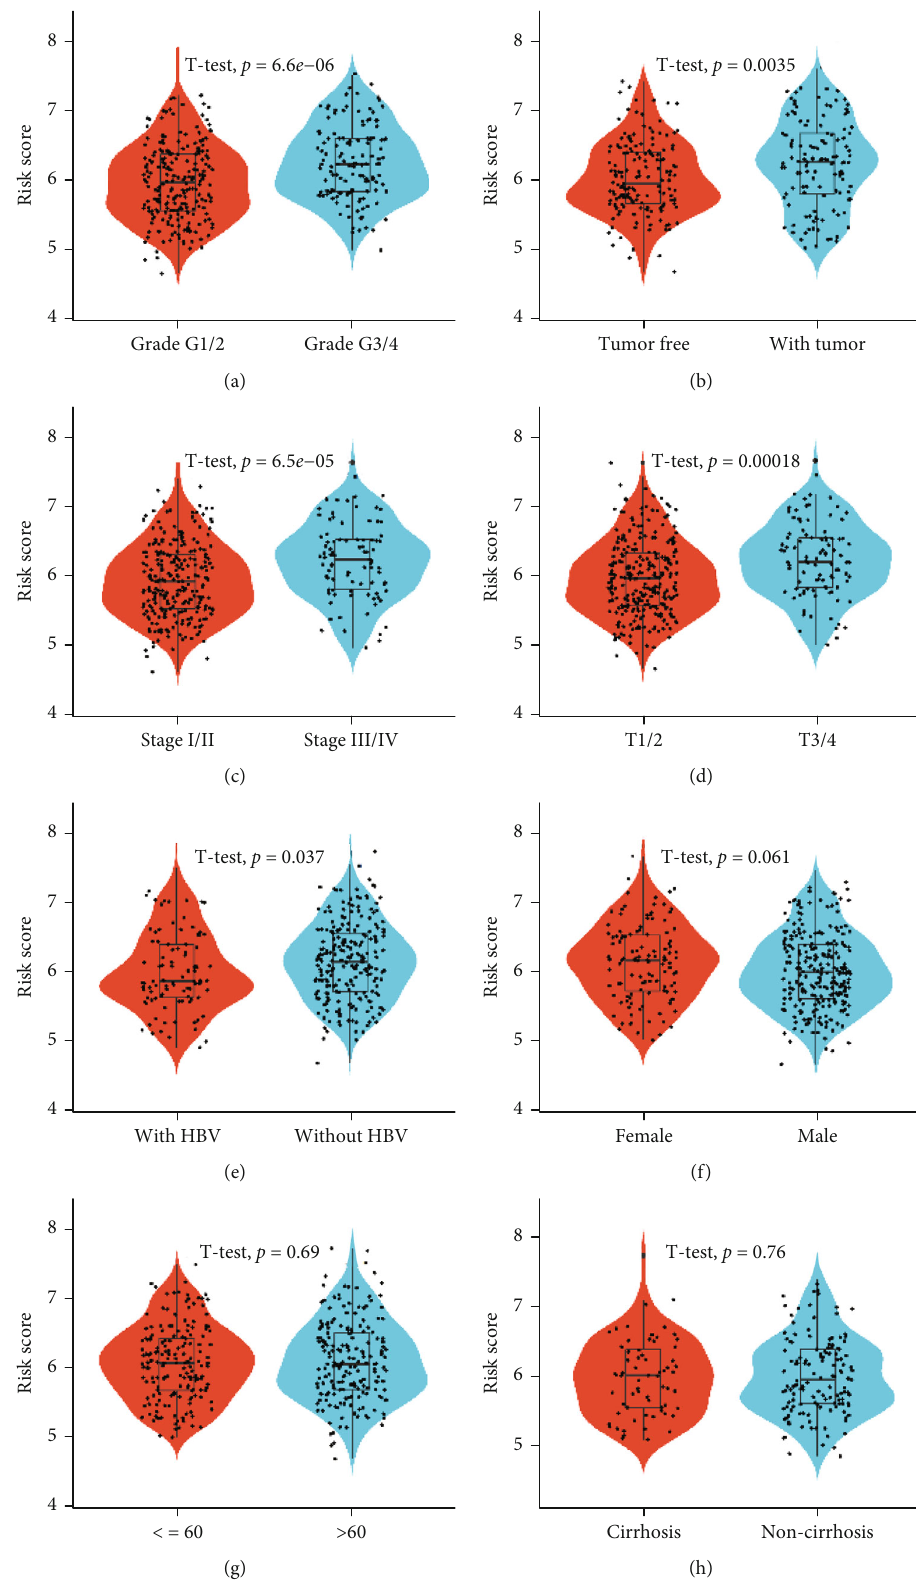
Figure 3: Higher risk scores were linked to later grade (a), recurrence (b), advanced TNM stage (c), later T stage (d), and HBV infection (e). As for age, gender, and cirrhosis status, no signi fi cant di ff erences were found (f –